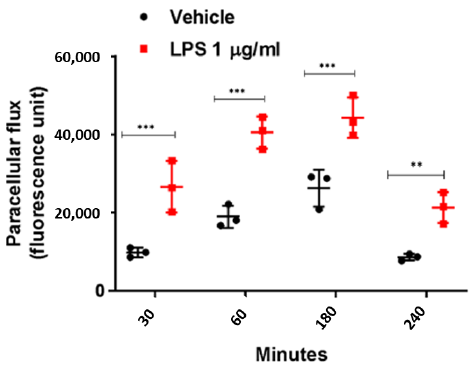
Figure A1. Paracellular flux on HUVECs exposed to LPS (1 µg/mL) in a time course experiment (from 30 min to 240 min). FITC-dextran transport in the lower compartment was measured at the end of LPS stimulation. ** p < 0.01; *** p < 0.001 vs. vehicle.